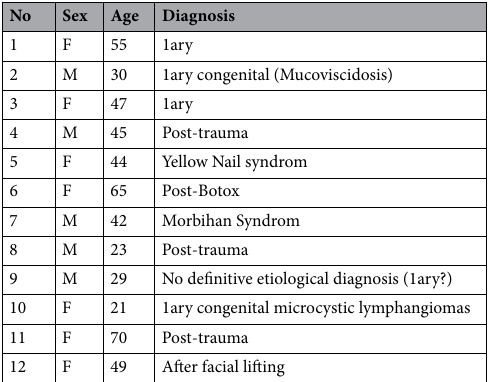
Table 1. Characteristics of the investigated patients with the etiological diagnosis of their edema at the level of the face. No. patient number, F female, M male.